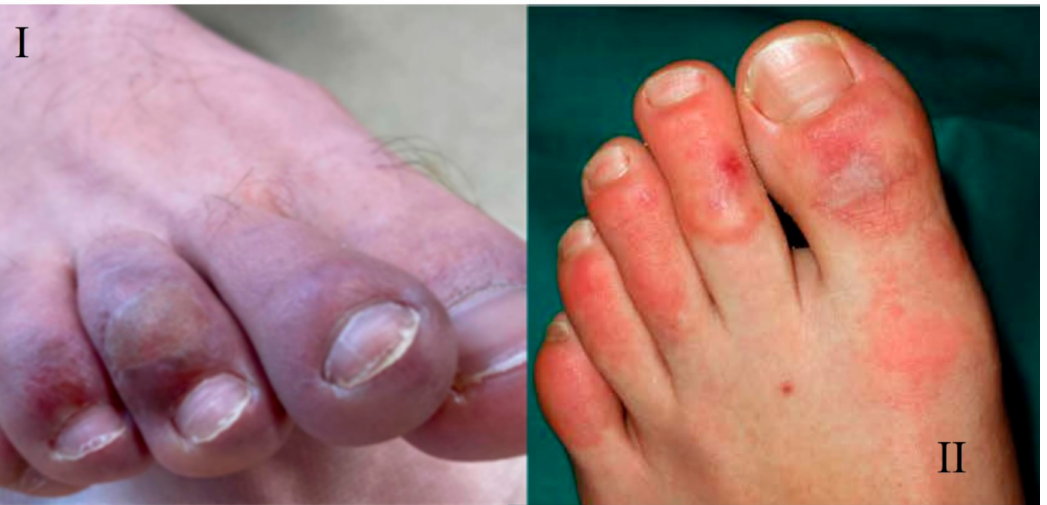
Figure 4. COVID fingers. ( I ) COVID-19 toes; ( II ) mixed pattern composed of dactyliotis and macula papules purpura. Arias-Arguello A. (2020)